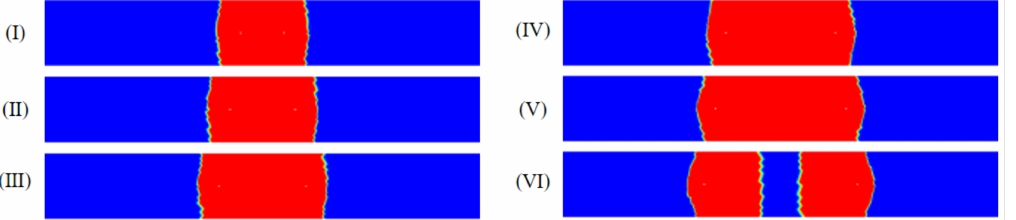
Figure 26. Range of gas pressure lower than 0.172 MPa at different borehole spacing: ( I) 4 m; ( II ) 6 m; ( III ) 8 m; ( IV ) 10 m; ( V ) 12 m; ( VI ) 14